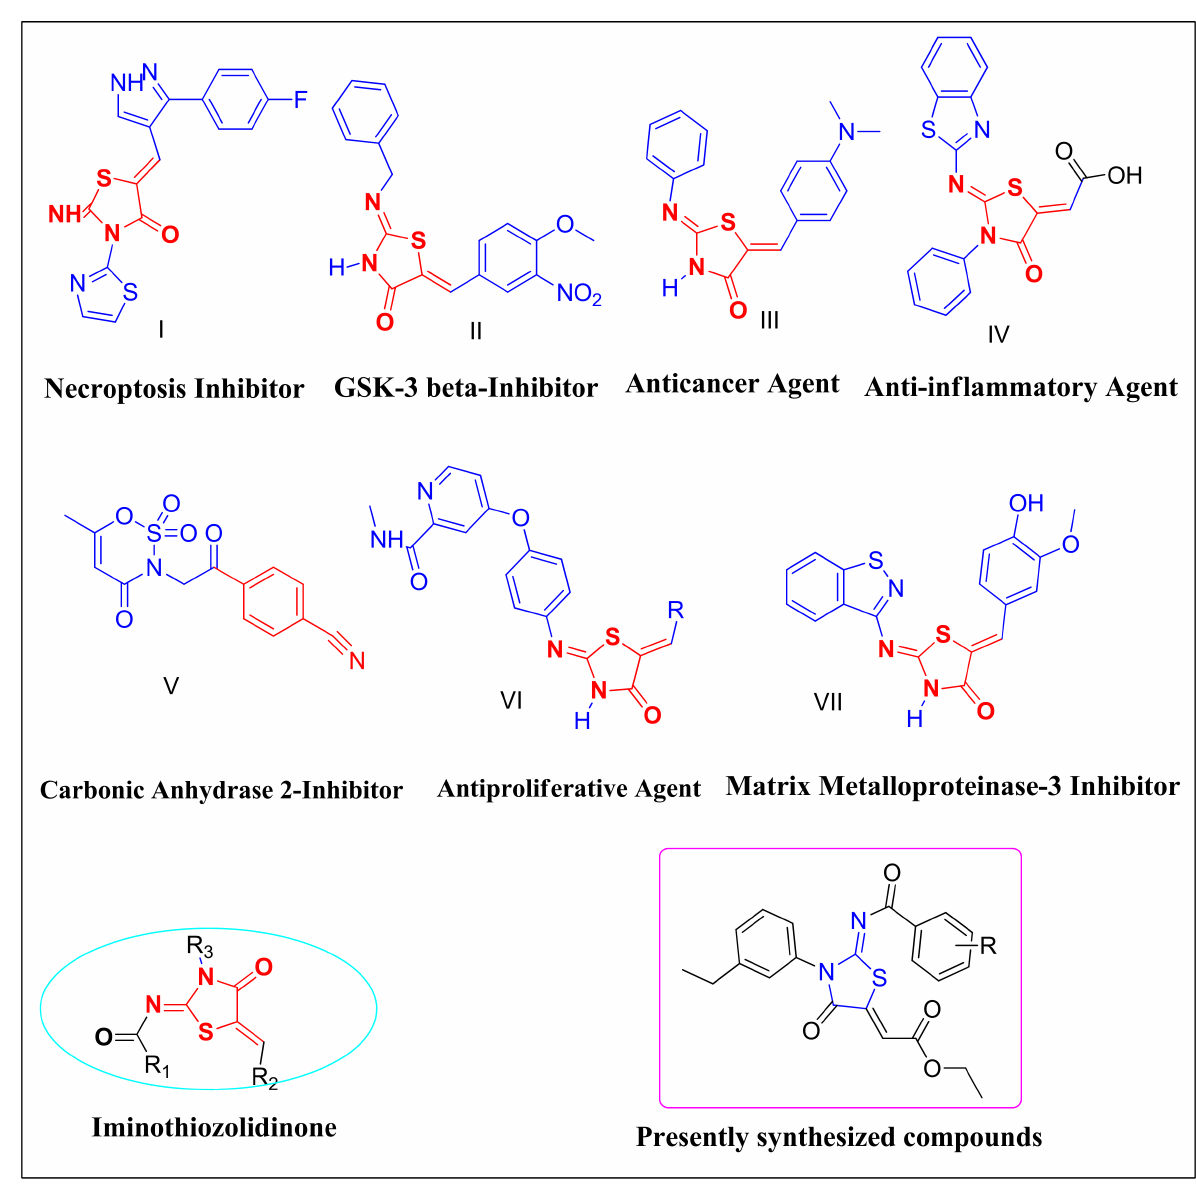
Figure 1. Illustration of pharmacologically important compounds possessing imino-thiazolidinone scaffold